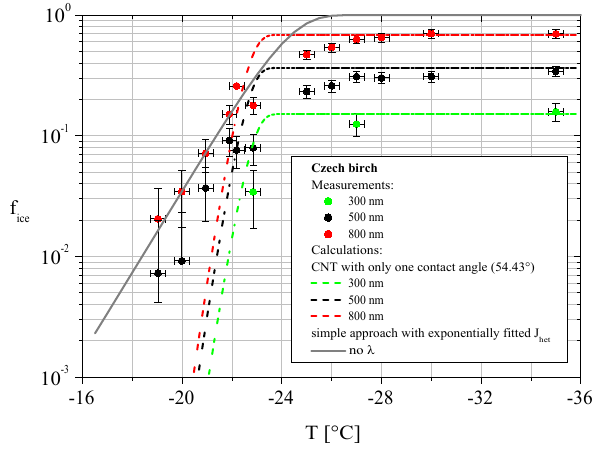
Fig. A1. Ice fraction f ice as a function of temperature T for 300, 500 and 800nm Czech birch pollen washing water particles (dots) and different model calculations. For explanations see Appendix